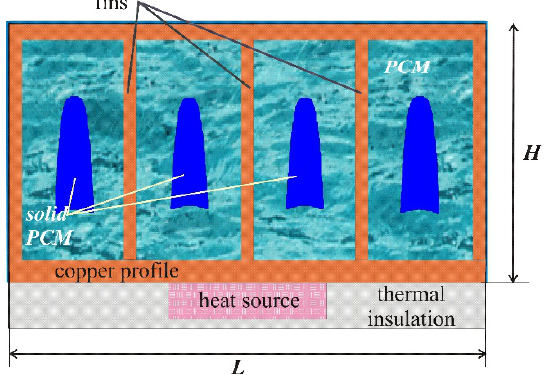
Figure 1. Domain of interest.